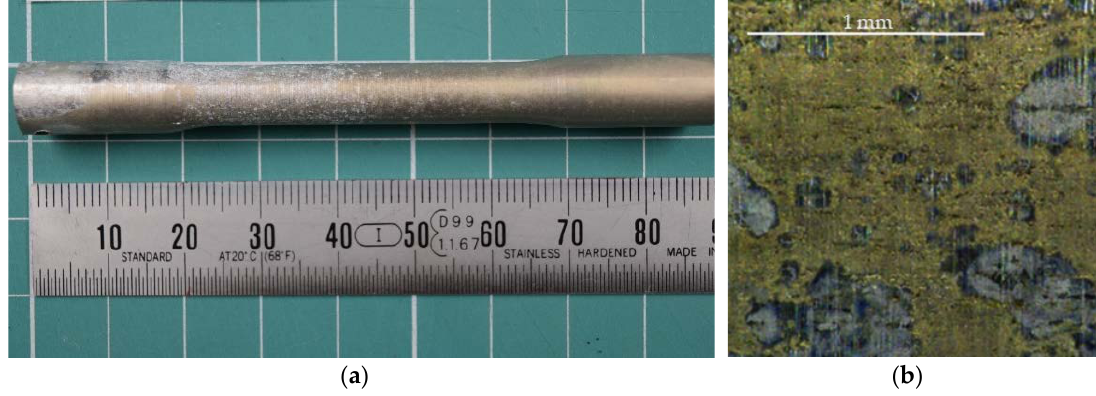
Figure 9. ( a ) General image of corroded specimen ( Vc = 60 m/min, f = 0.2 mm/r). ( b ) Detail (×72) of the corroded surface.